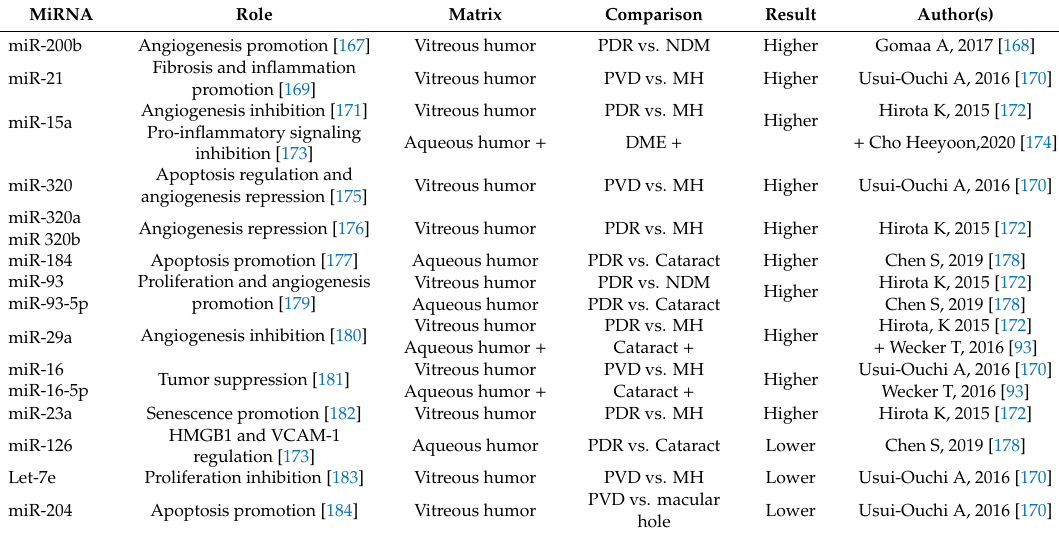
Table 2. miRNA’s found in human eye fluids of patients. A comparison of some of the most commonly found miRNAs in vitreous or aqueous humor from patients with and without proliferative diabetic disease, MH: macular hole without any other condition, DME: diabetic macular